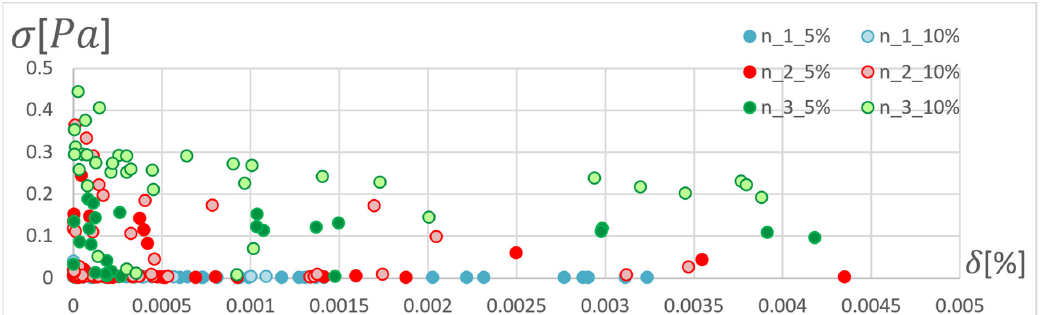
Figure 11. Pareto fronts for all networks trained using the GDM algorithm, in the zone of highest accuracy.